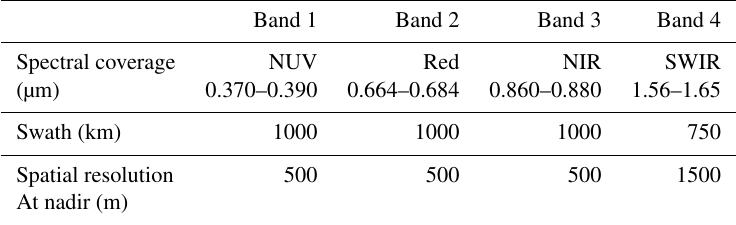
Table 1. Specifications of CAI.